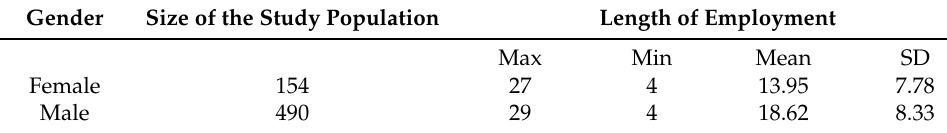
Table 2. Statistics of seniority in number of years based on different